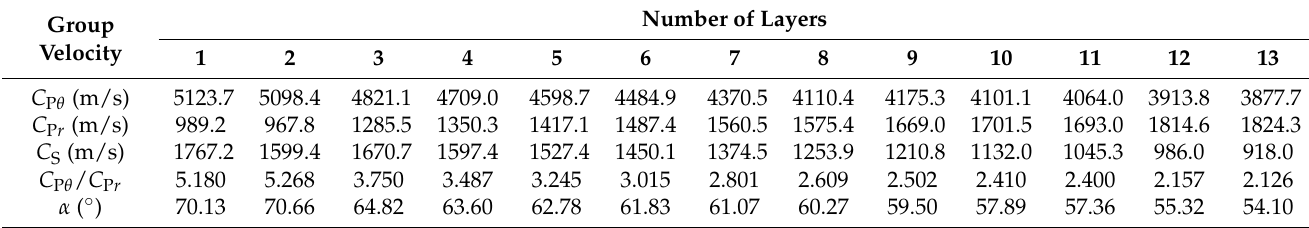
Table 3. Group velocities of cells for the pentamode lattice-ring structure.